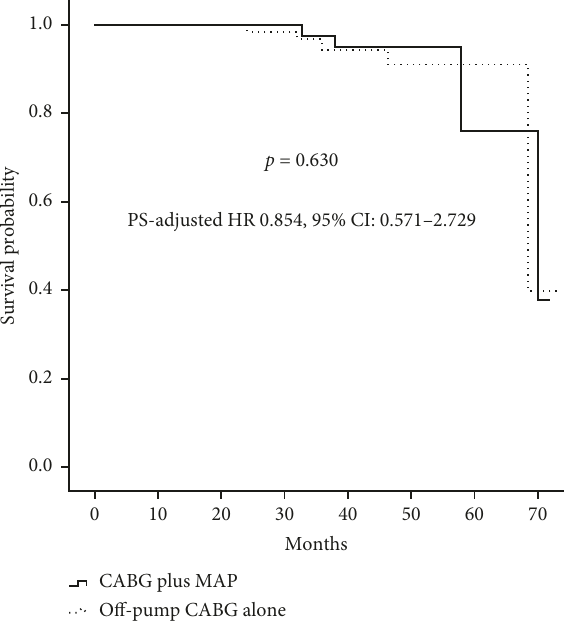
Figure 4: Survival probability using PS-adjusted Cox regression analysis. PS, propensity score; HR, hazard ratio; CI, confidence